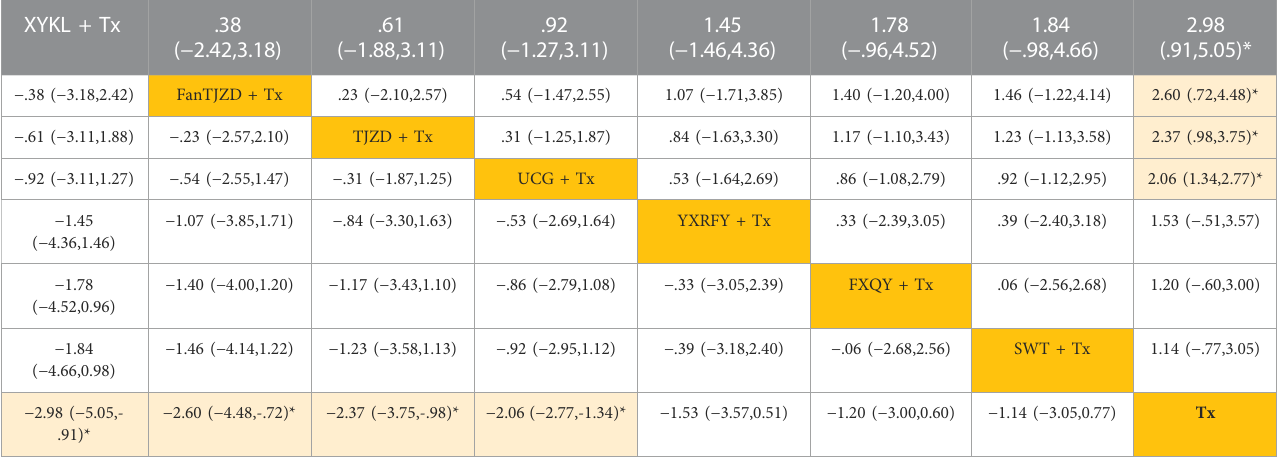
TABLE 2 Netleague table comparing different Chinese herbal medicine treatments in terms of visual analog scale.